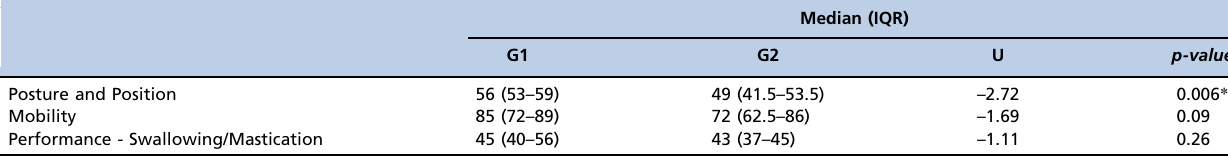
Table 1 - Evaluation of the Expanded Protocol of Orofacial Myofunctional Evaluation with Scores in deep partial-thickness burns – G1 (n=19) and full-thickness burns – G2